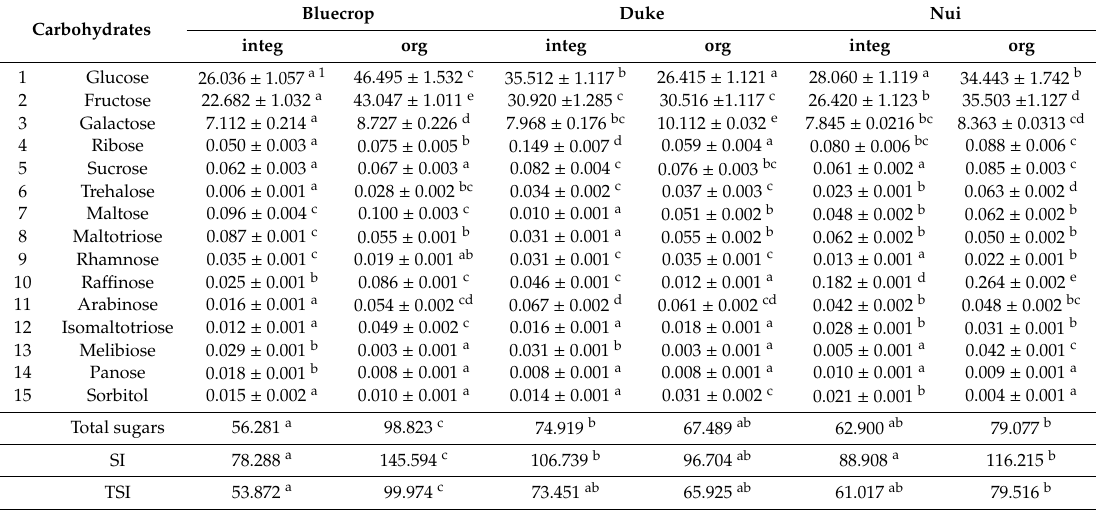
Table 2. Average contents of carbohydrates (mg / g), sweetness index (SI) and total sweetness index (TSI) in integrated (integ) and organic (org) blueberry fruits from three replications. Bluecrop Duke Nui Carbohydrates